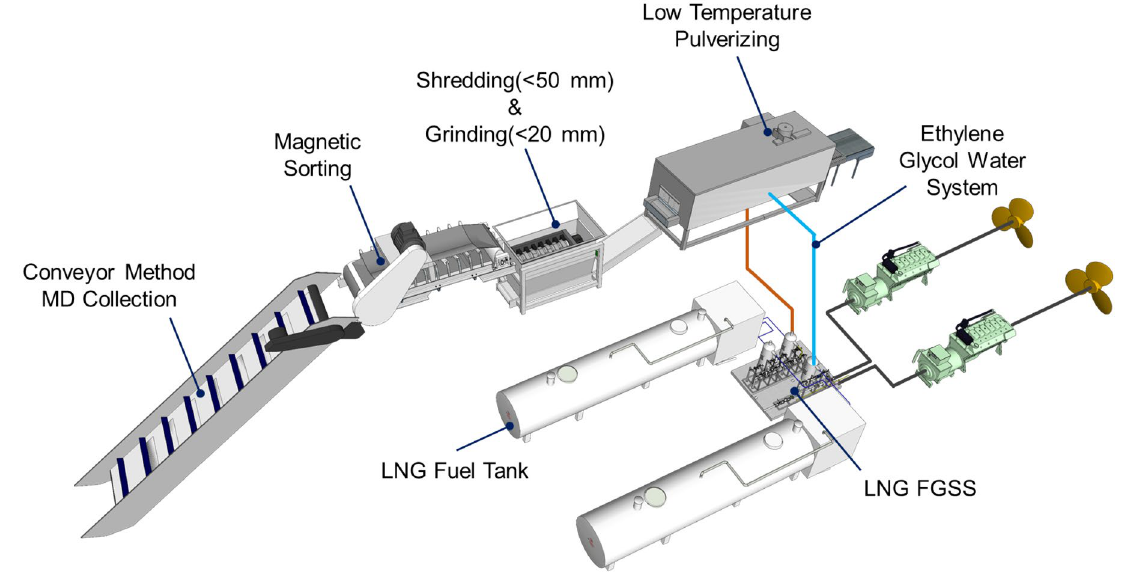
Figure 1. Layout for LNG-fueled propulsion system equipped with an LTP system utilizing LCE.